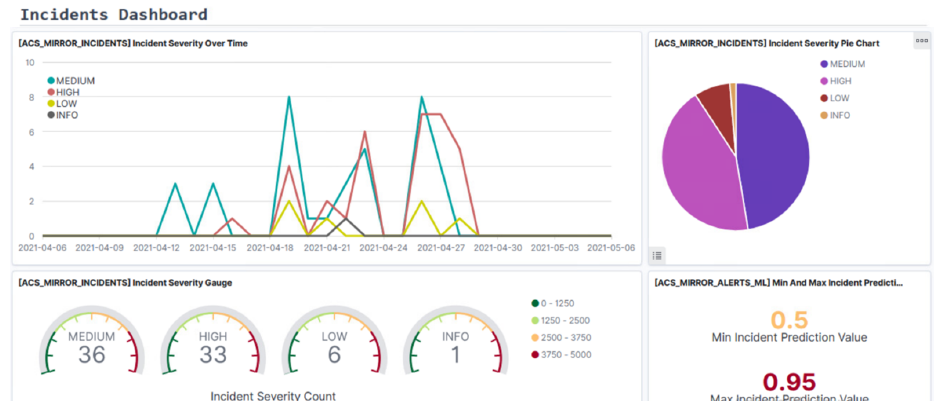
Figure 13. Incidents Dashboard—Incidents severity monitoring visualizations.